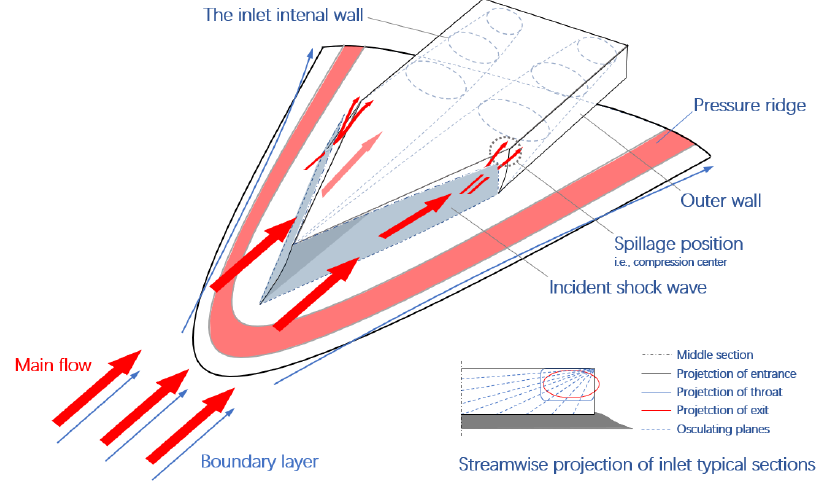
Figure 3. New spillage ‐ adaptive integration concept with the wide speed range.